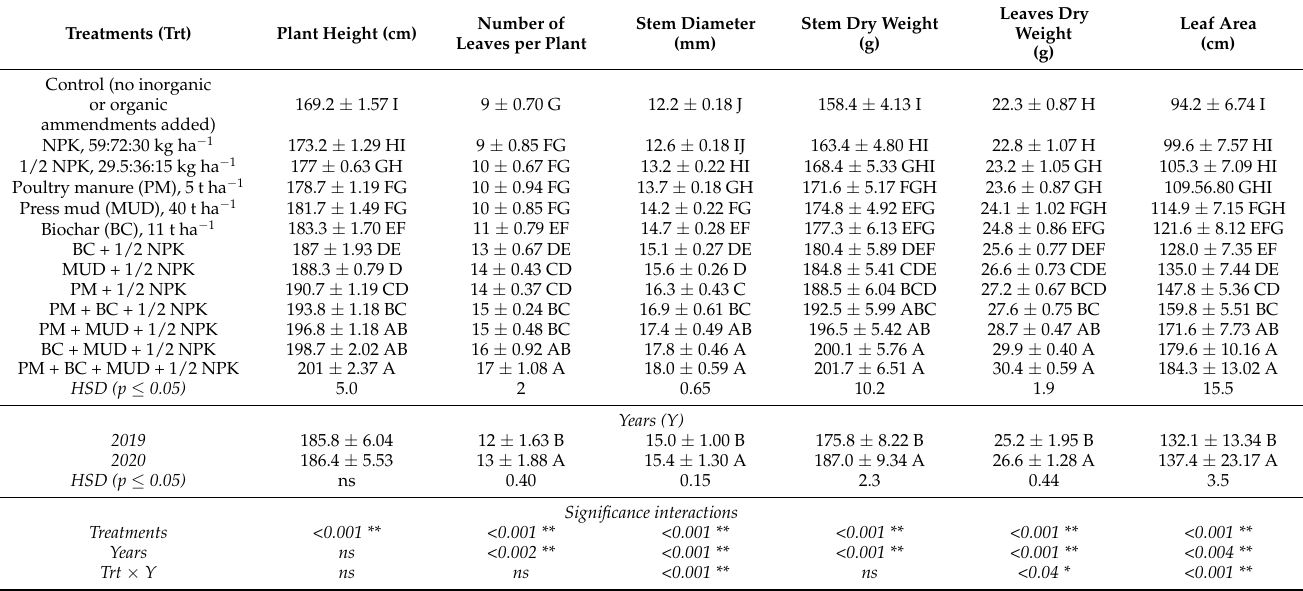
Table 2. Performance for plant height, number of leaves, stem diameter, stem/leaves dry weight, and leaf area of forage sorghum at different organic amendments under field conditions of Layyah, Pakistan, during 2019 and